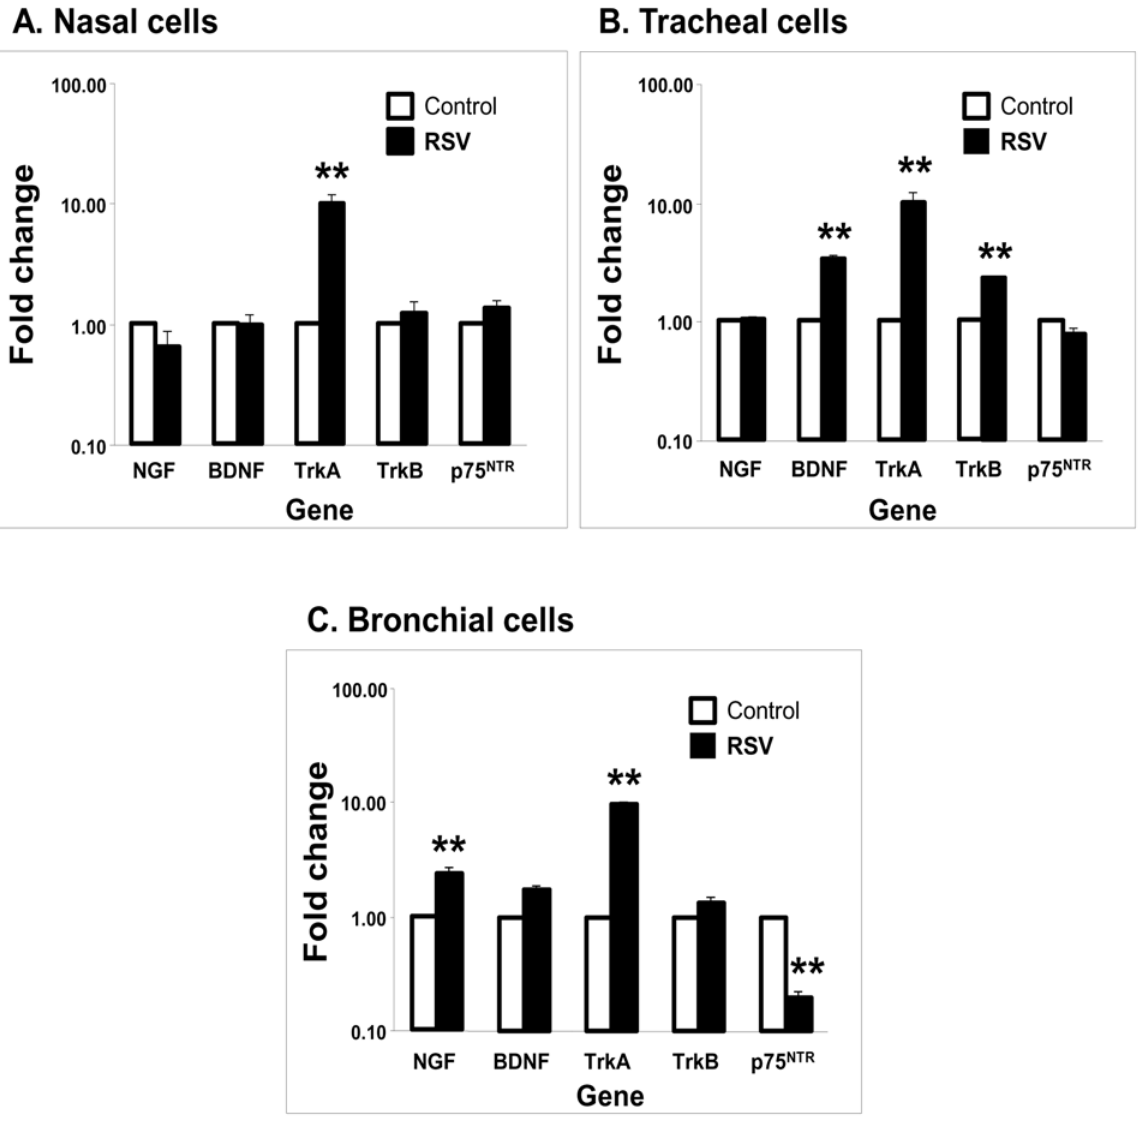
Figure 5. RSV-induced changes in neurotrophins gene expression in (A) nasal epithelial cells; (B) tracheal epithelial cells; and (C) bronchial epithelial cells. Cells were infected with 1 MOI of rgRSV for 24 h; then, RNA was isolated and cDNA synthesized for real-time PCR analysis. C t values were normalized to the housekeeping gene HPRT1. Data shown are the average of 4 independent experiments performed in duplicate, and are presented as the mean 6 SEM (n=8). **= p , 0.01 compared to non-infected